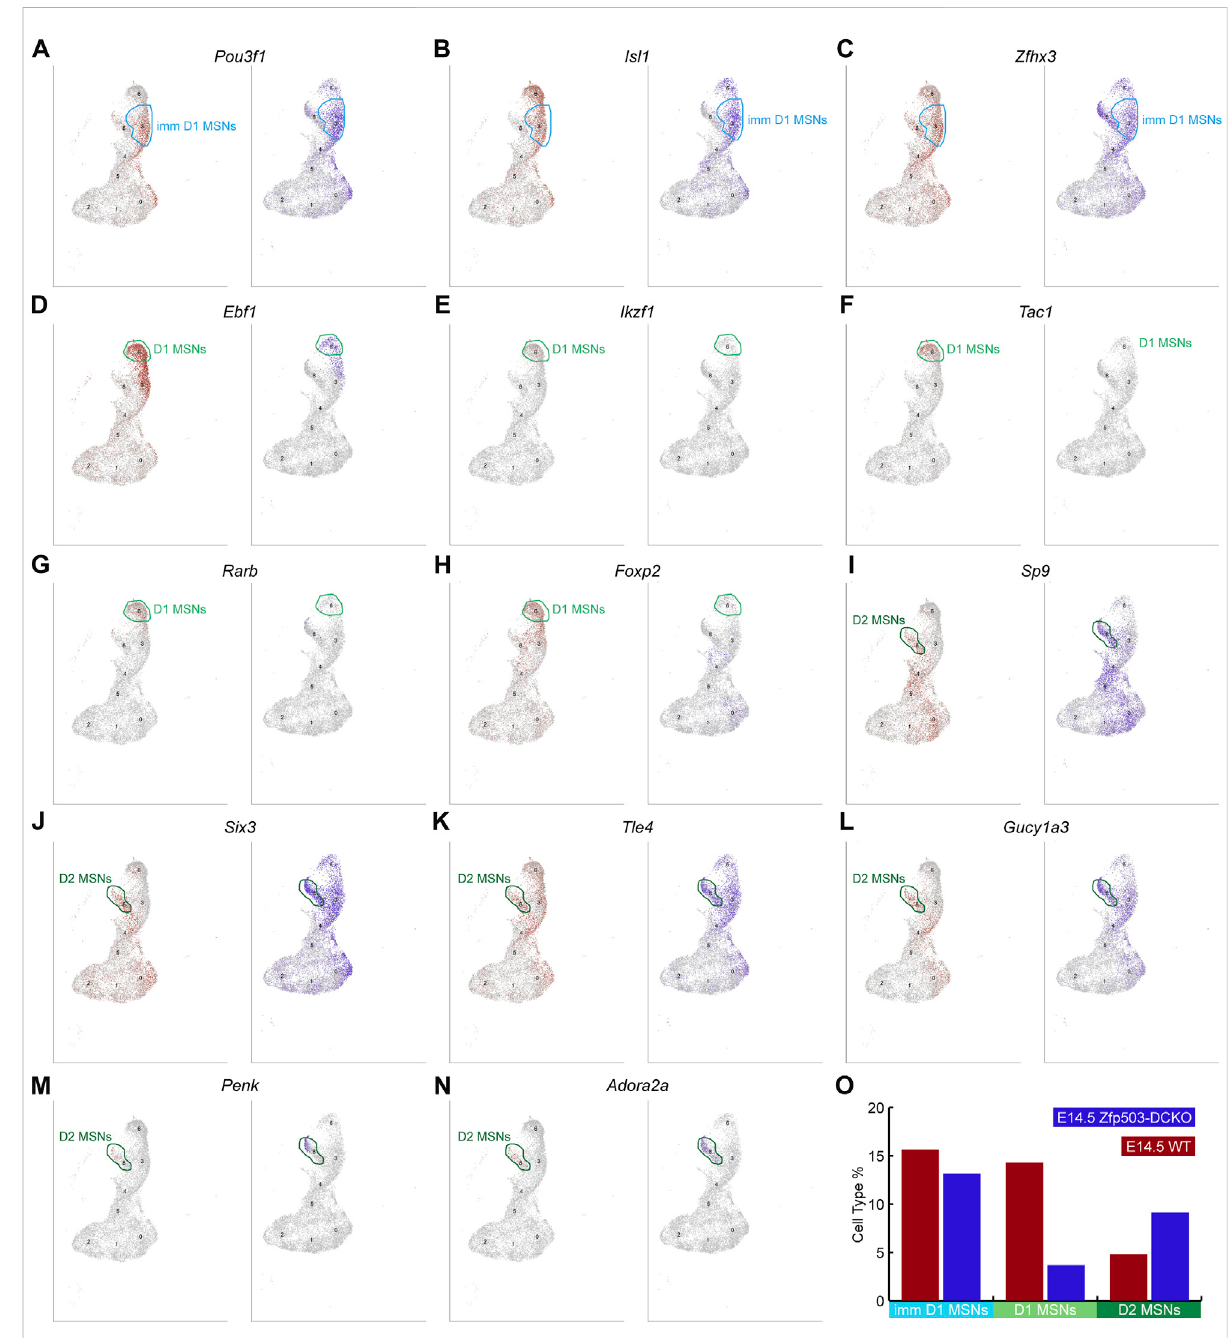
scRNA-seqrevealsthat Zfp503 promotestheD1MSNidentityandrepressestheD2MSNidentity. (A-C) Therewerenosigni fi cantchangesinthe expressionofimmatureD1MSNmarkers,including Pou3f1 , Isl1, and Zfhx3, between Zfp503 -DCKOmiceandWTmice. (D-H) Theexpressionof Ebf1 , Ikzf1 , Tac1 , Rarb, and Foxp2 was decreased in Zfp503 -DCKO mice. (I-N) The expression of Sp9 , Six3 , Tle4 , Gucy1a3 , Penk, and Adora2a was increased in Zfp503 -DCKO mice compared to WT mice. (O) The cell types percentage in Zfp503 -DCKO mice and WT